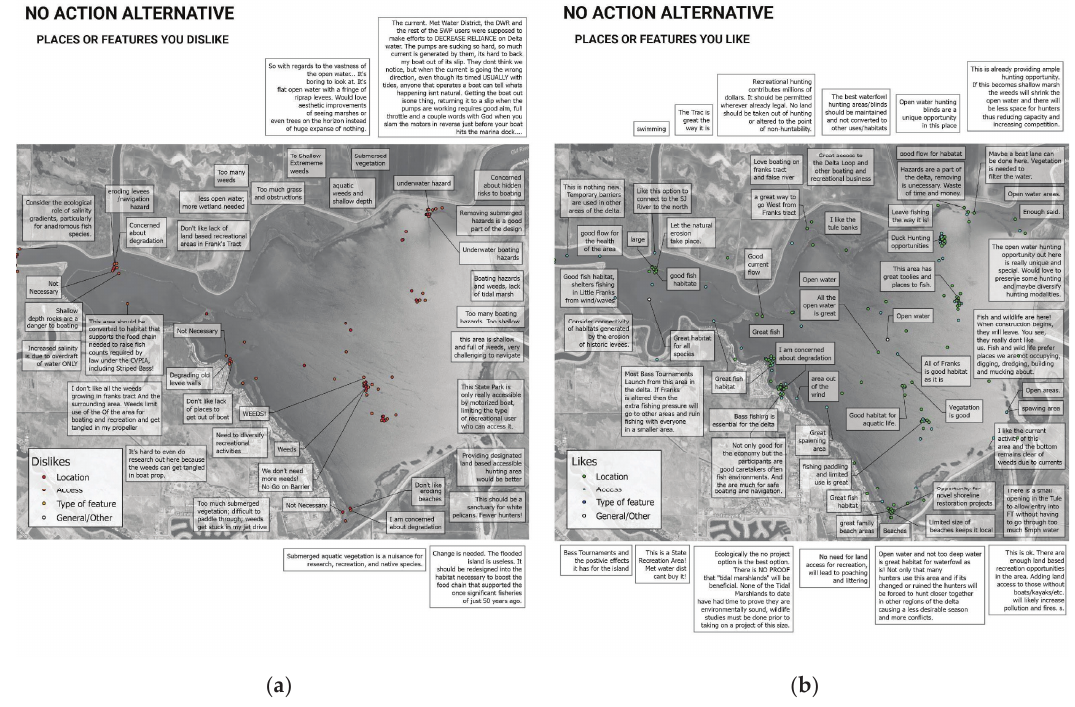
Figure 15. No Action Alternative (NAA) community comments. ( a ) Places or features you dislike for NAA ( b ) Places or features you like for